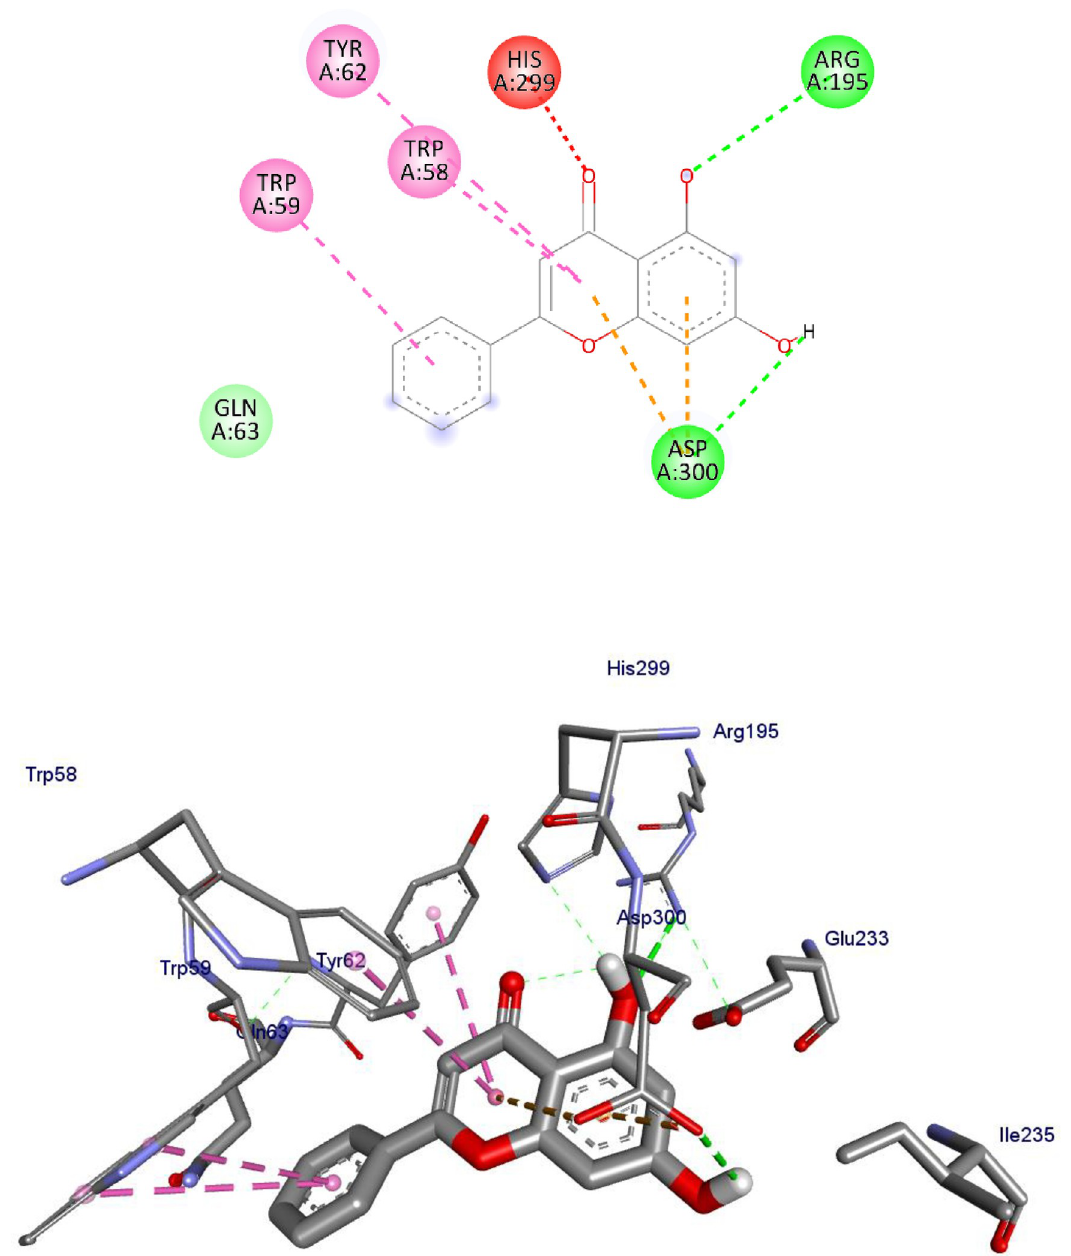
Fig 4. 2D (upper panel) and 3D (lower panel) representations of the binding modes of chrysin to Human α -amylase (PDB ID: 4W93).